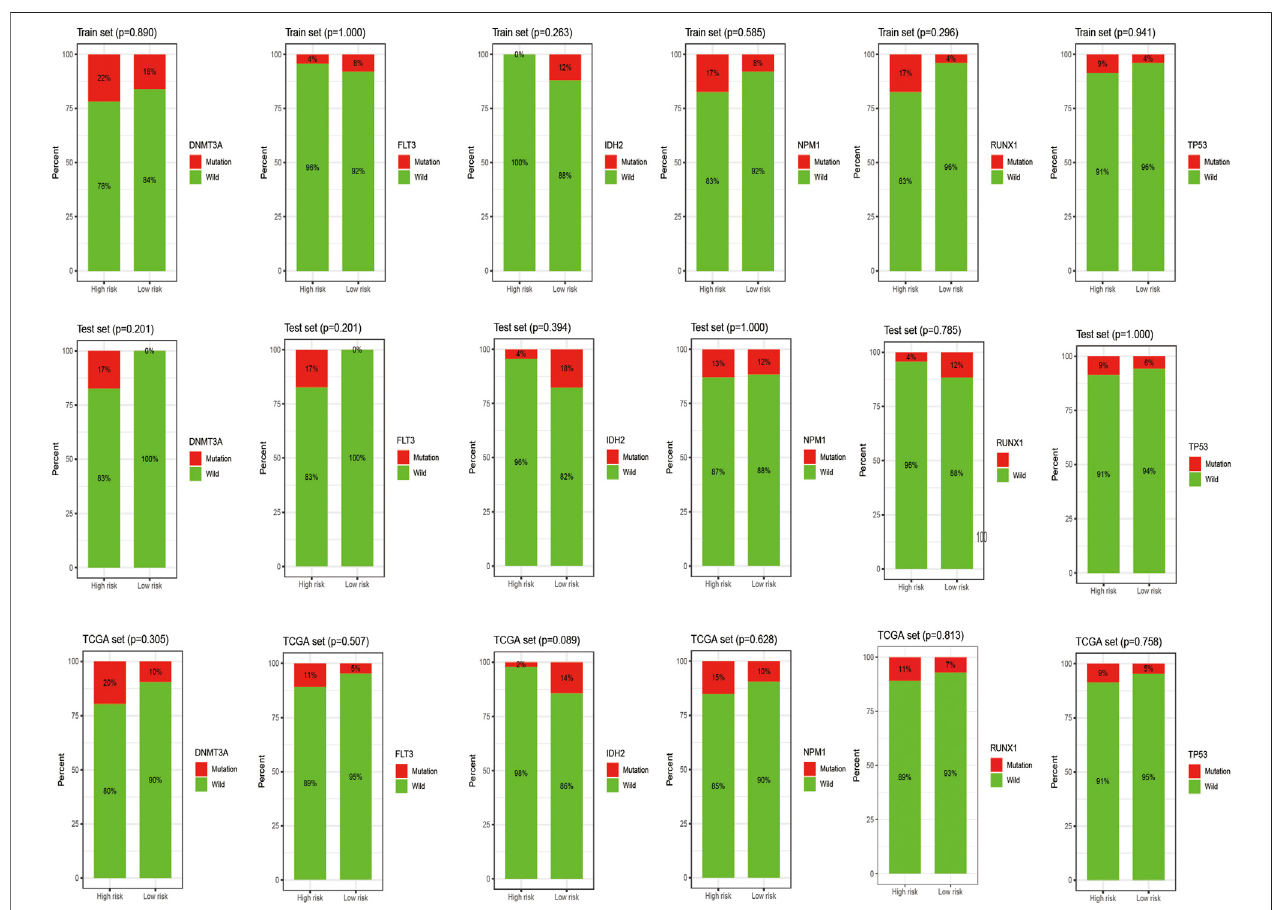
FIGURE 9 | Histogram of the mutation frequency of common mutation genes in the train, test and overall groups. The X -axis represents the high- and low-risk groups, and the red on the Y -axis represents the ratio of samples with corresponding gene mutations.